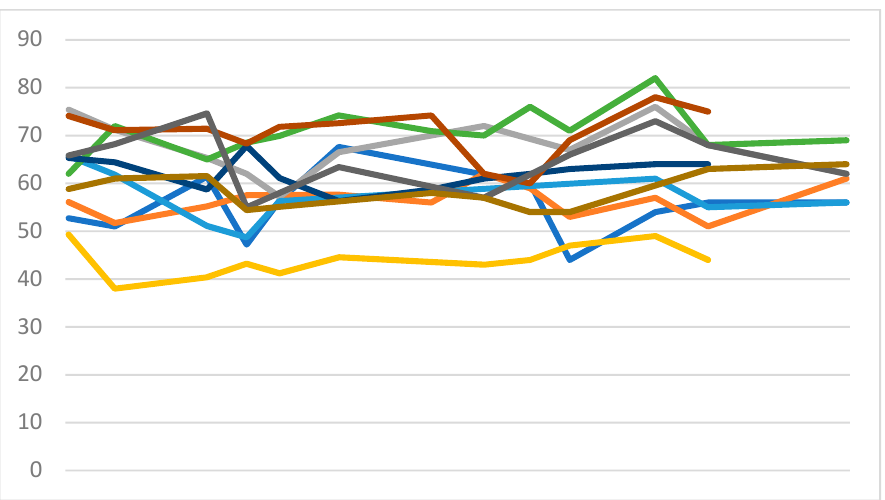
Figure 2. Heart rate. Each line represents the measurement of one player over time. Unit of measure: Beats per minute. The x axis represents the weeks of measurement.